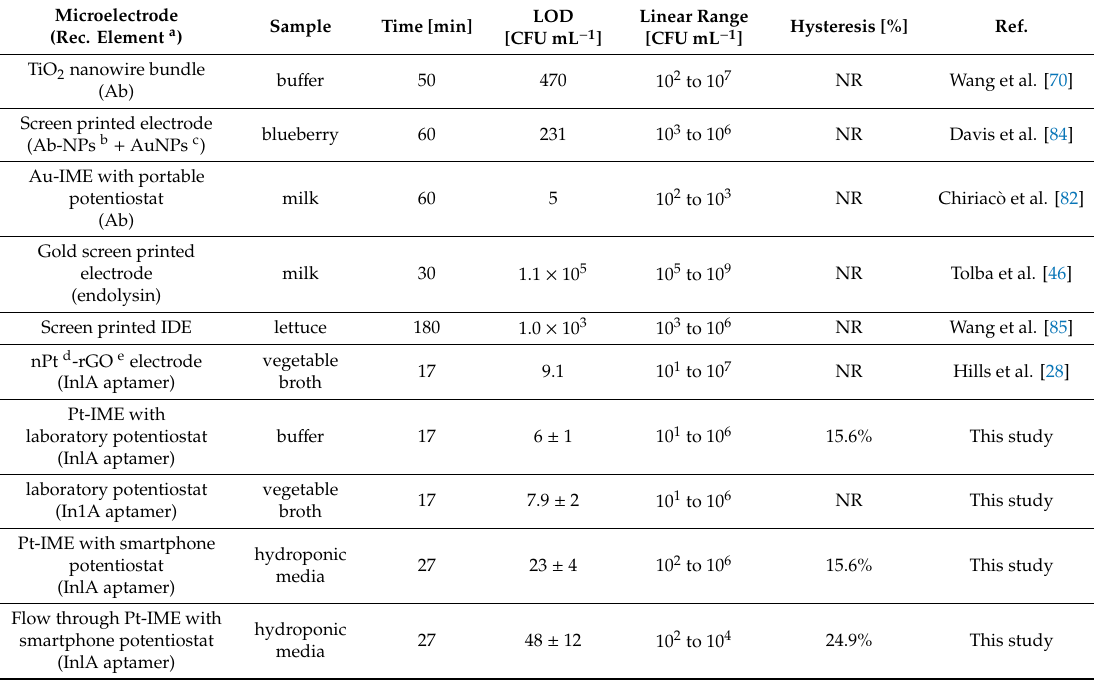
Table 2. Comparison of impedimetric biosensors for the detection of Listeria